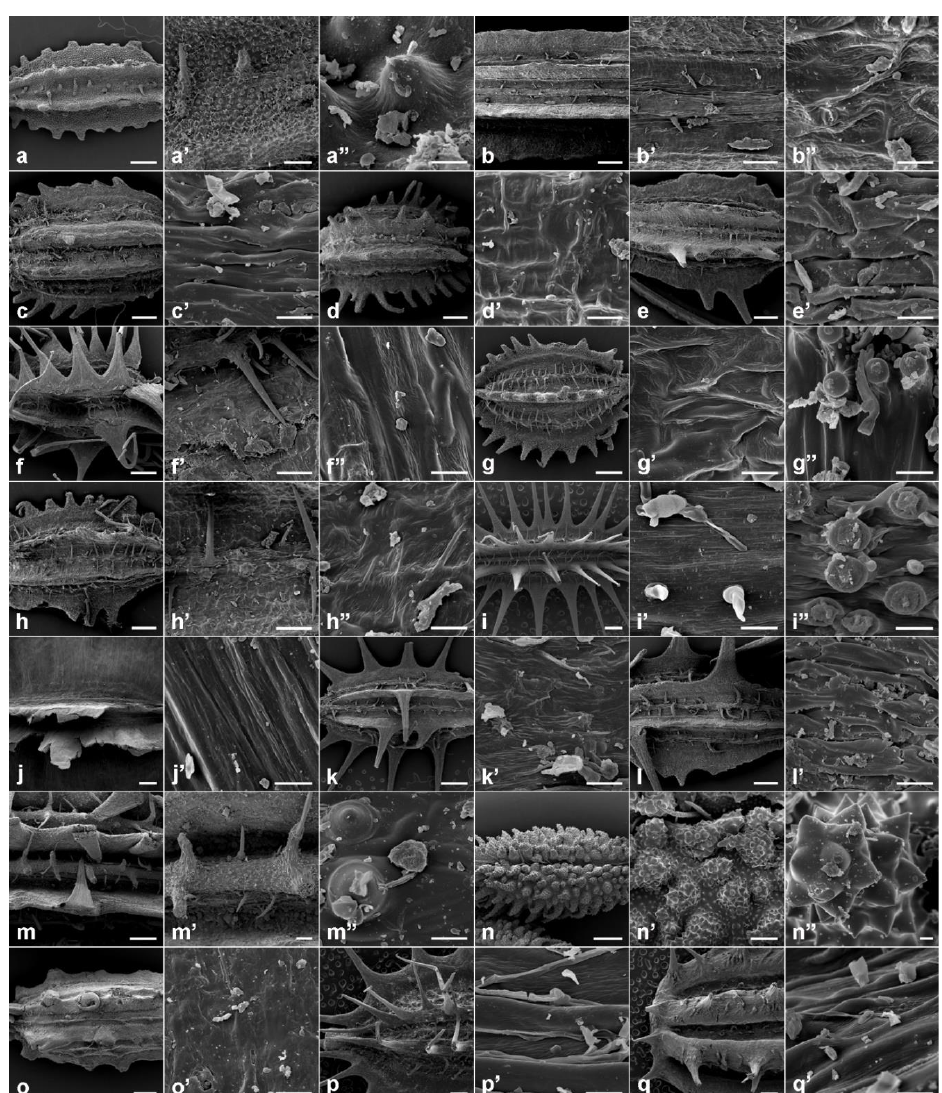
Figure 3. Fruit morphology and its surface micromorphology of the investigated Daucus and closely related non- Daucus taxa by scanning electron microscopy. ( a – a” ) D . aureus : ( a ) dorsal view and close-ups on ( a’ ) the median primary rib and ( a” ) tubercle; ( b – b” ) D . carota subsp. capillifolius : ( b ) dorsal view and close-ups on ( b’ ) the median primary rib and ( b” ) surface between ribs; ( c , c’ ) subsp. sativus (DH): ( c ) dorsal view, ( c’ ) close-up on the surface between ribs; ( d – d’ ) subsp. sativus (‘Dolanka’): ( d ) dorsal view, ( d’ ) close-up on the surface between ribs; ( e , e’ ) D . pusillus : ( e ) dorsal view, ( e’ ) close-up on the surface between ribs; ( f – f” ) D . conchitae : ( f ) dorsal view and close-ups on ( f’ ) the primary rib and ( f” ) surface between ribs; ( g – g” ) D . guttatus : (g) dorsal view and close-ups on ( g’ ) the surface between ribs and ( g” ) tubercles; ( h – h” ) D . involucratus : ( h ) dorsal view and close-ups on ( h’ ) the median primary rib and ( h” ) surface between ribs; ( i – i” ) D . littoralis : ( i ) dorsal view and close-ups on ( i’ ) the surface between ribs and ( i” ) tubercles; ( j , j’ ) D . rouyi : ( j ) dorsal view, ( j’ ) close-up on the surface of the wing; ( k , k’ ) D . sahariensis : ( k ) dorsal view, ( k’ ) close-up on the surface between ribs; ( l , l’ ) D . syrticus : ( l ) dorsal view, ( l’ ) close-up on the surface between ribs; ( m – m” ) D . muricatus : ( m ) dorsal view and close-ups on ( m’ ) the primary rib and ( m” ) tubercles; ( n – n” ) Torilis arvensis : ( n ) dorsal view and close-ups on ( n’ ) the additional secondary ribs and ( n” ) tubercle; ( o – o’ ) Caucalis platycarpos : ( o ) dorsal view, ( o’ ) close-up on the surface between ribs; ( p , p’ ) Orlaya daucoides : ( p ) dorsal view, ( p’ ) close-up on the surface between ribs; ( q , q’ ) O . daucorlaya : ( q ) dorsal view, ( q’ ) close-up on the surface between ribs. Scale bars: 600 µ m ( i , j , o – q ); 400 µ m ( a , f , g , k , m , n ); 300 µ m ( b – e , h , l ); 100 µ m ( a’ , b’ , f’ , h’ , m’ , n’ ); 10 µ m ( c’ – e’ , g’ , i’ – l’ , o’ – q’ , a” , b” , f” – i” , m” , n”